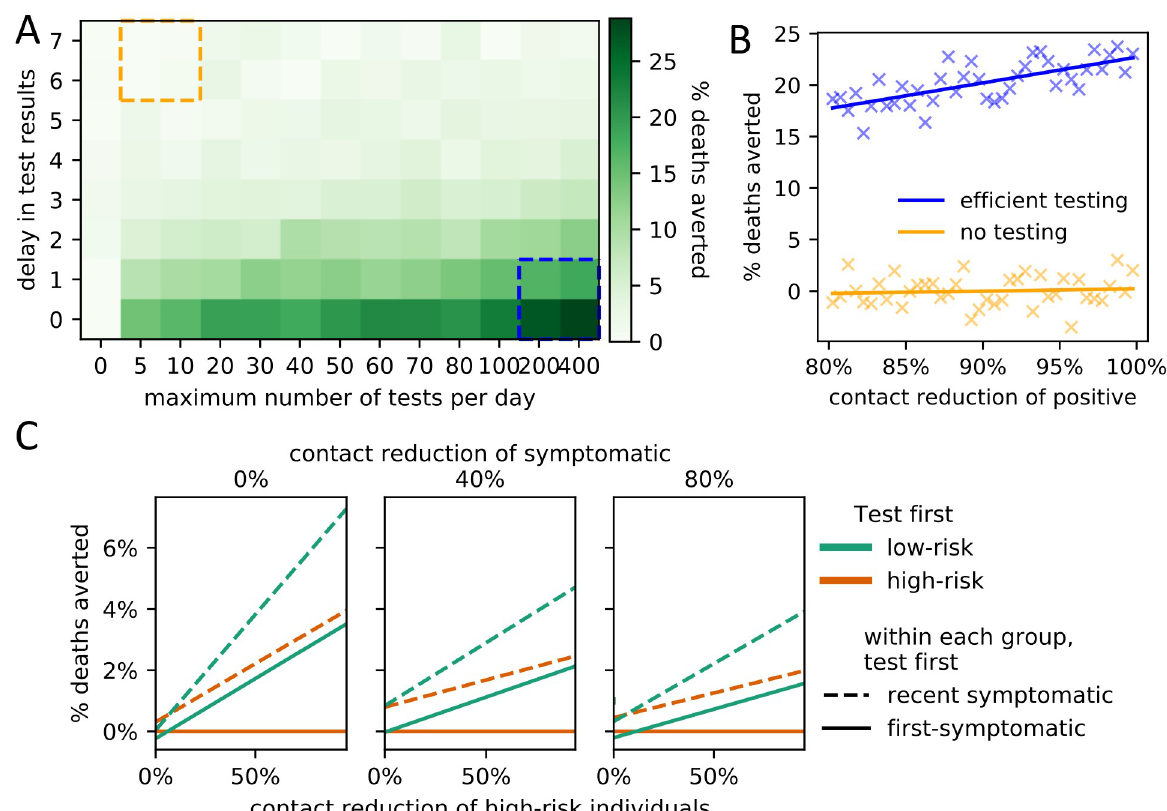
Fig 5. Impact of testing policies on COVID-19-related mortality. (A) Effect of increased numbers of tests (x-axis) and processing delays (y-axis) on the average percentage of averted deaths (compared to no testing; left-most column). (B) Effect (linear regression) of the average contact reduction by individuals with positive test results on the percentage of averted deaths under an efficient testing scenario (blue box lower right in A) and an inefficient testing scenario (orange box upper left in A). (C) Impact of policies regarding testing prioritization of symptomatic individuals on the average percentage of averted deaths (compared to the worst policy). The primary policy decision involves which risk group to prioritize (low-risk (green) or high-risk (orange)). The secondary policy decision involves who to test first within each risk group (newly symptomatic (solid lines) or first-symptomatic (dashed lines)). The results are stratified for three different levels of additional contact reduction due to symptoms (subplots) as well as for varying levels of additional contact reduction of high-risk individuals (x-axis). Linear regression fits are